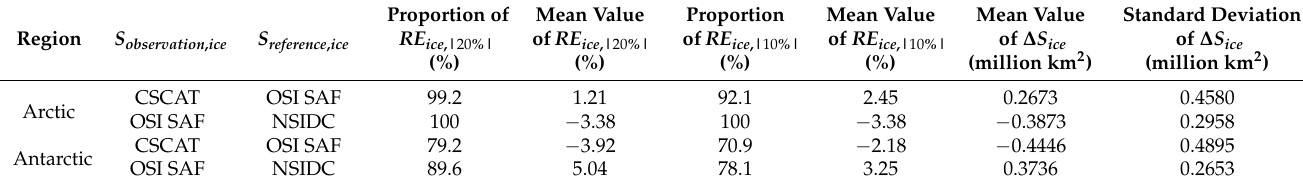
Table 7. Statistics of the comparisons between CSCAT, OSI SAF, and NSIDC sea ice area. Region S observation , ice S reference ,